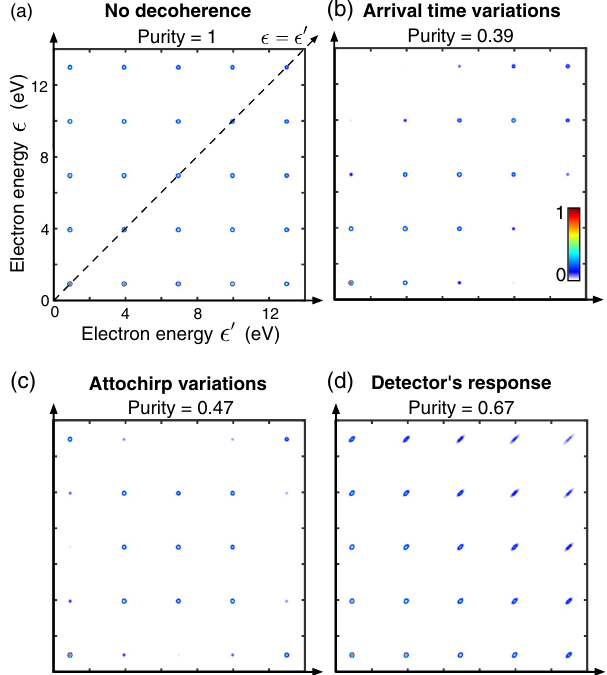
FIG. 7. Simulated density matrices in various cases. (a) The electron wave packet is pure, (b) the XUV pulses suffer from arrival-time variations, or (c) attochirp variations. (d) The XUV pulse ensemble is fully coherent, but the limited resolution of the spectrometer is accounted